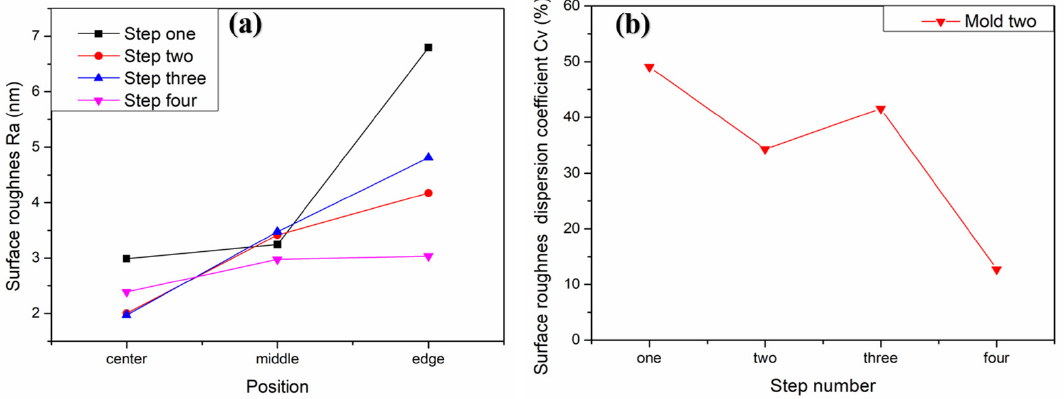
Figure 19. Mold two: ( a ) Comparison diagram of SR changes in the center, middle, and edge of the aspherical surface during polishing process; ( b ) Change diagram of SR dispersion coefficient.